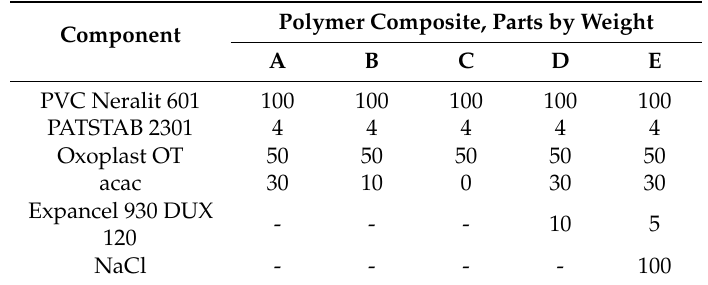
Polymer Composite, Parts by Component